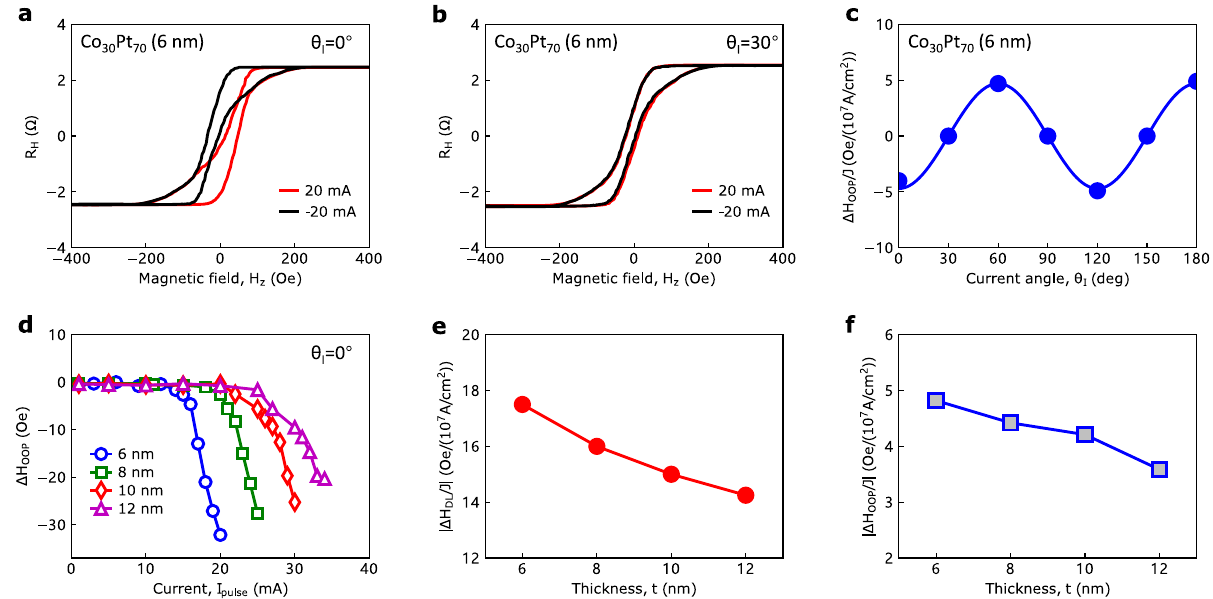
Fig. 3 Current-induced out-of-plane and in-plane SOT effective fi elds. a , b AHE loops under + 20 and − 20 mA pulsed currents for θ I = 0° ( a ) and 30° ( b ). c Current angle dependence of the out-of-plane effective fi eld ef fi ciency ( Δ H OOP / J ) in 6 nm Co 30 Pt 70. d Current dependence of Δ H OOP for various Co 30 Pt 70 thicknesses. e , f Thickness dependences of in-plane and out-of-plane SOT effective fi elds for θ I = 0°, respectively. The Δ H OOP for the largest measured current in ( d ) is used for the calculation in ( f